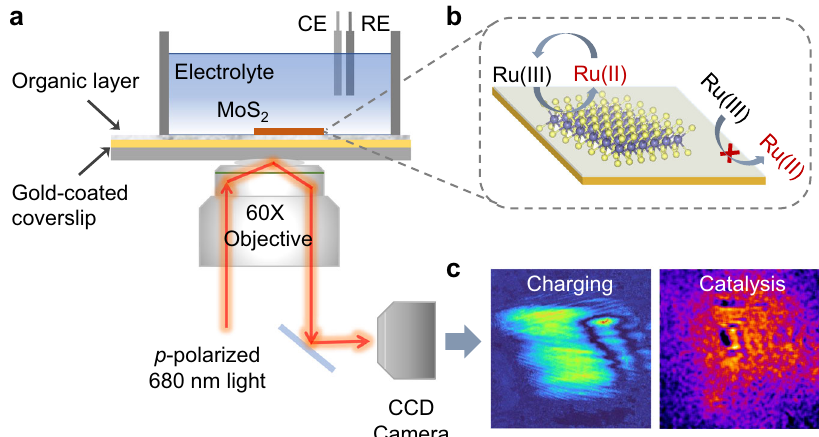
Fig. 1 | Plasmonic imaging of the electrochemical reactions of single MoS 2 nanosheets. a Experimental setup. b Schematic depicting the removal of the interference from the gold fi lm, which was passivated by a self-assembled